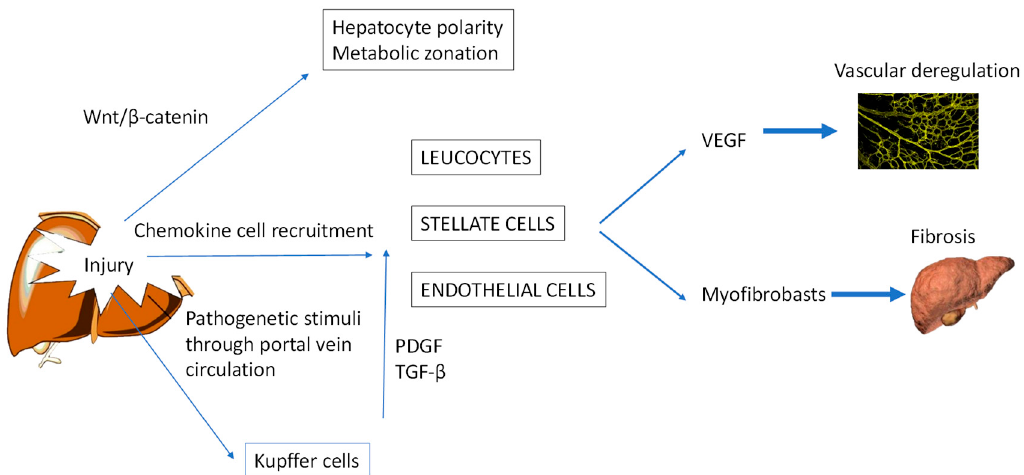
Figure 2. Crosstalk among mediators of liver injury. In the absence of Wnt ligands, the Wnt / β -catenin signalling pathway is mostly inactive. During cell regenerative processes and in certain pathological conditions, the Wnt / β -catenin signal is activated. Wnt / β -catenin signalling controls several processes such as cell growth, di ff erentiation and polarisation. Chemokines released by Kup ff er cells during liver injury recruit several cell types such as leukocytes, hepatic stellate cells (HSCs) and endothelial cells to the site of injury. These cells regulate the extracellular VEGF-mediated processing of vascular permeability and angiogenesis and, through the di ff erentiation of HSCs to myofibroblasts, promote fibrosis. Kup ff er cells become activated when they phagocytise blood-borne pathogens transported by the portal circulation. Current evidence suggests that these cells are the principal e ff ectors of fibrogenic PDGF- and TGF- β -mediated signalling, which activate HSCs and regulate extracellular matrix accumulation. VEGF, vascular endothelial growth factor; PDGF, platelet-derived growth factor; TGF- β , transforming growth factor